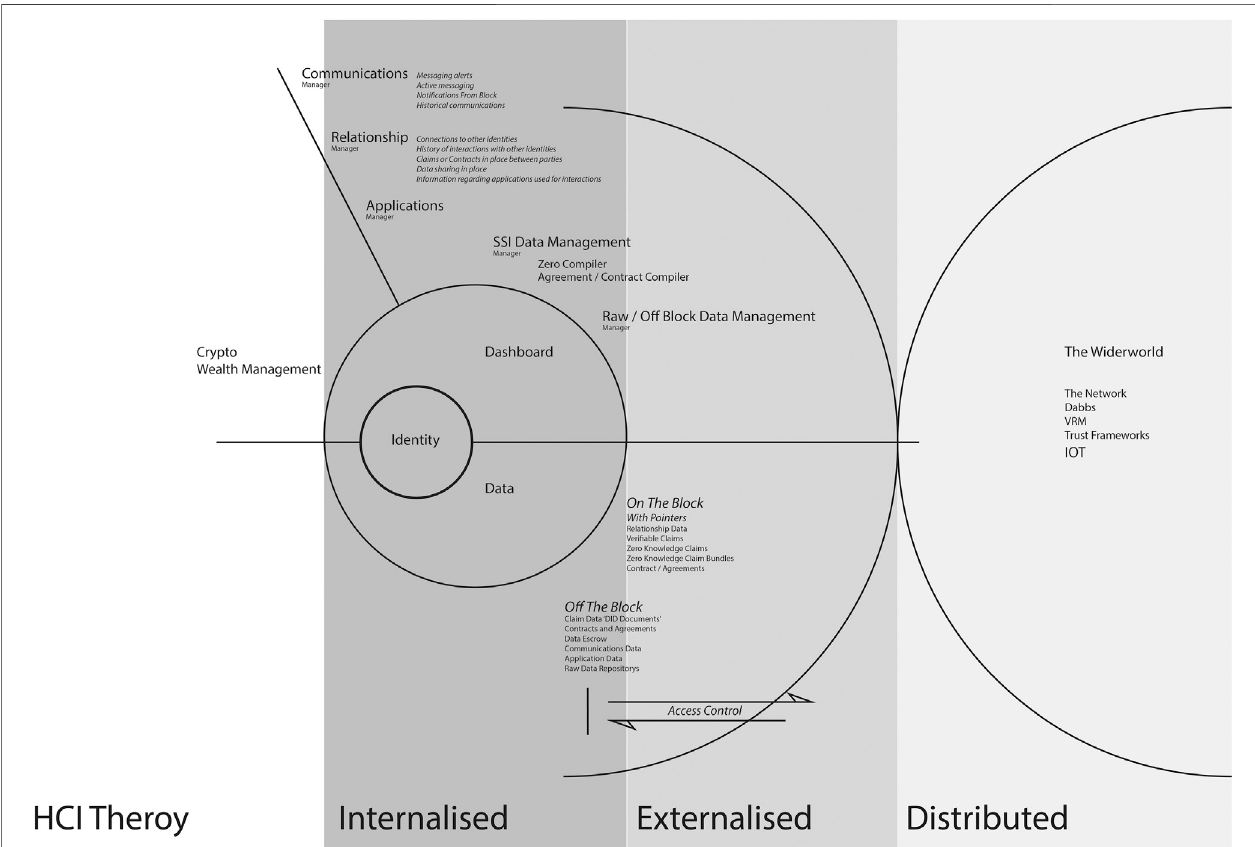
FIGURE 4 | The relevant HCI cognitive theory across a human-centered data ecosystem.